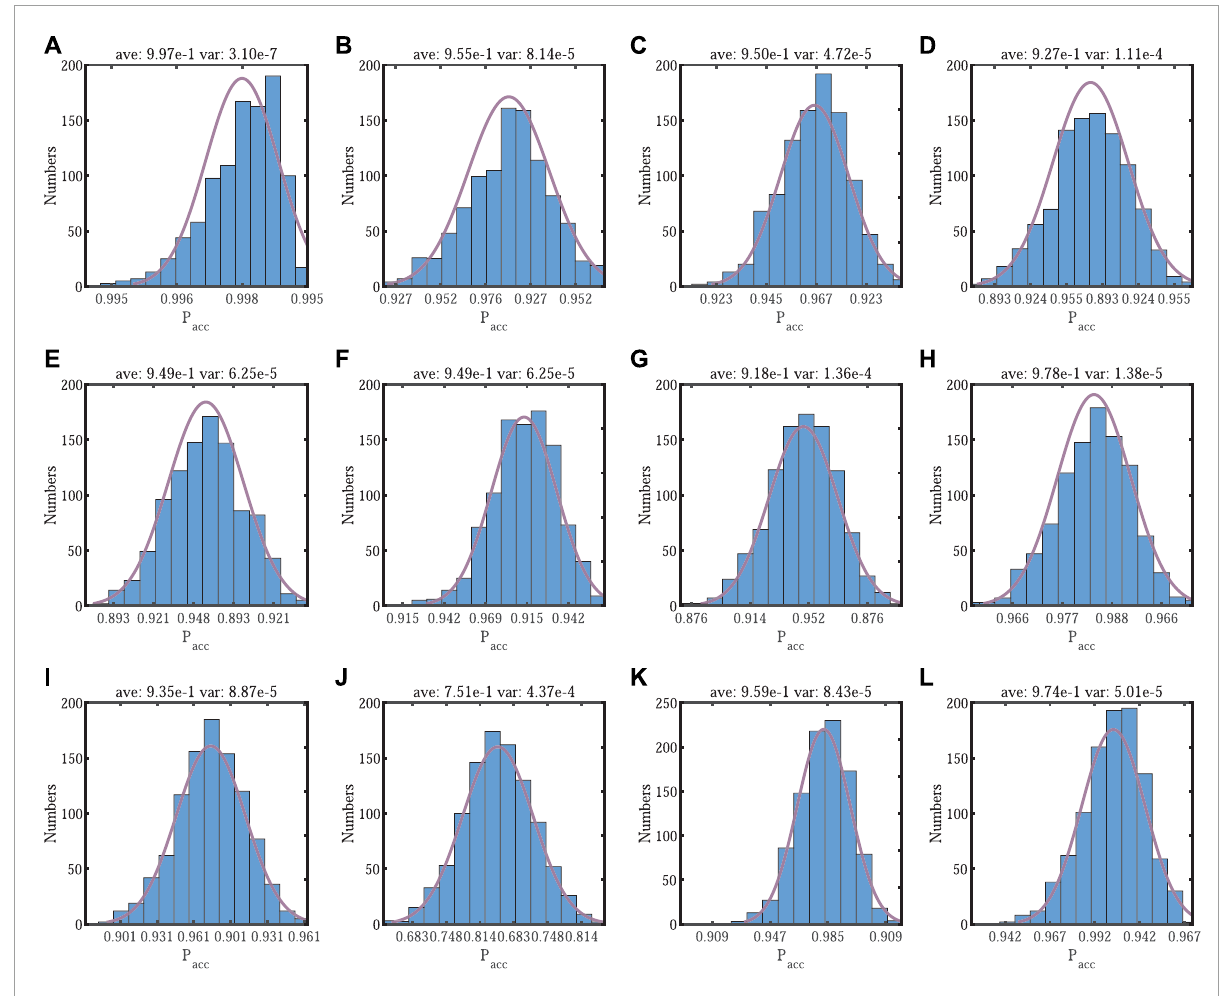
FIGURE 6 P acc distribution of the algorithms in the test of three JH-10 modules in series connection with random PSCs: (A) VVS; (B) VS; (C) ABCA; (D) CS; (E) FAO; (F) FPO; (G) HHO; (H) Jaya; (I) PSO; (J) SFLA; (K) TLBO; (L) WCA.